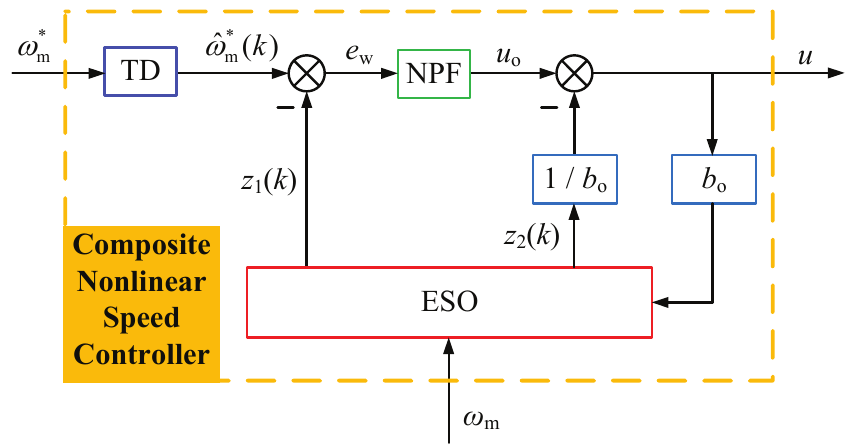
Figure 1. The composite nonlinear speed